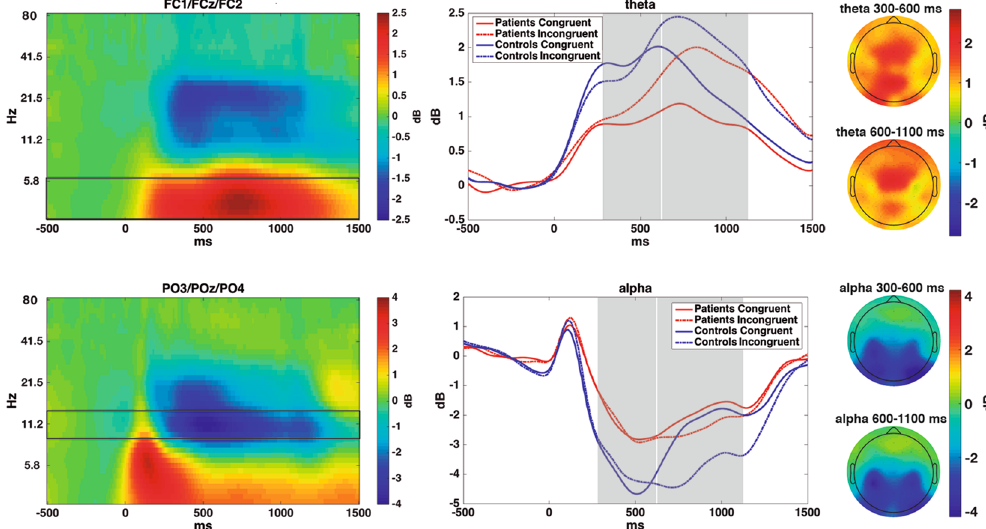
Figure 3. Left: Time-frequency power modulations over midfrontal and posterior locations, averaged between groups and conditions. Boxes show the frequency ranges depicted in the left column. Middle: Time course of theta and alpha power modulations for each condition and group; Grey boxes show the time windows used for statistical comparisons. Right: Topographies -averaged between conditions and groups- for each frequency and time